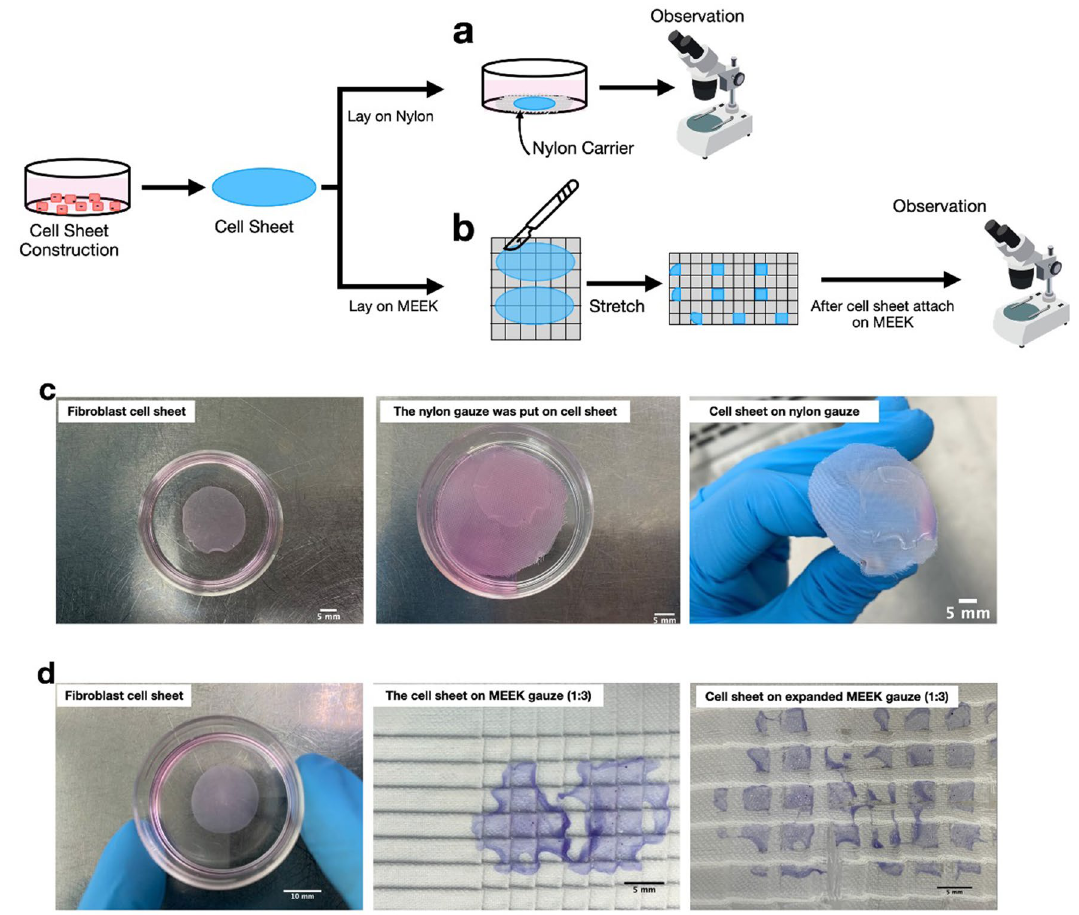
Figure 1. A brief schematic representation of the experimental procedure for transferring fibroblast cell sheets onto nylon dressing and MEEK gauzes. After the cell sheet was harvested from the temperature-responsive culture surface, ( a ) the sheet was immediately transferred to sterile nylon dressing before observation. Otherwise, ( b ) the cell sheet was transferred to prefolded MEEK gauze. Afterwards, the sheet was cut vertically and horizontally using a surgical blade. Then, the MEEK gauze was stretched to all sides to separate the cell sheet into many small cell islands. ( c ) The nylon dressing was overlaid on top of the fibroblast sheet before it was flipped using forceps, allowing the cell sheet to face up. ( d ) The fibroblast sheet was transferred onto the MEEK gauze before being cut and stretched, showing several square cell islands. Note that the cells were stained with trypan blue for ease of culture dish surface. Within 3 days, the cells migrated from the cell sheet islands and reattached onto the new culture surface, and those cells continuously proliferated. As shown in Fig. 4a, on day 7, many more cells were found on the surface and had spread to most areas. Clearly, the cells migrated from the edge of the previously occupied cell sheet islands, indicated by the red arrows. On day 14, the reattached fibroblast cells became more confluent and denser, occupying the empty spaces. On day 21, the cells grew and migrated through the inside sheet island area, providing the whole culture surface coverage. Cell confluency was determined and is shown in Fig. 4b. The average cell confluency was initially lower than 20% but continuously increased to 100% by day 21. However, the differences in confluence between the different expansion ratios were not statistically significant. This result shows that MEEK gauze could allow cell reattachment and enable prolonged cell cultivation, provid- ing high confluency within 21 days. Cell migration of fibroblast sheets on the nylon dressing and MEEK gauze at 1:3, 1:6 and 1:9 expansion ratios. Cell migration on nylon dressing and MEEK gauze was investigated, as it is the funda- mental process of tissue homeostasis and wound healing. The fibroblast migration patterns on the nylon dressing and MEEK gauzes at expansion ratios of 1:3, 1:6 and 1:9 are shown in Fig. 5, where the dotted lines indicate the initial edge of the cell sheets on the nylon dressing or the cell sheet islands on MEEK gauzes. Since the cell sheets on the MEEK gauzes were cut into smaller islands, clear straight-line edges with dense cells were observed. Unlike the MEEK technique, the cell sheet was directly placed onto the nylon dressing, showing a gradient of cell density around the periphery. Consequently, the cells on the nylon dressing could immediately migrate along the fiber toward less crowded areas with elongated morphology, as shown in Fig. 5 and Supplementary S1. On